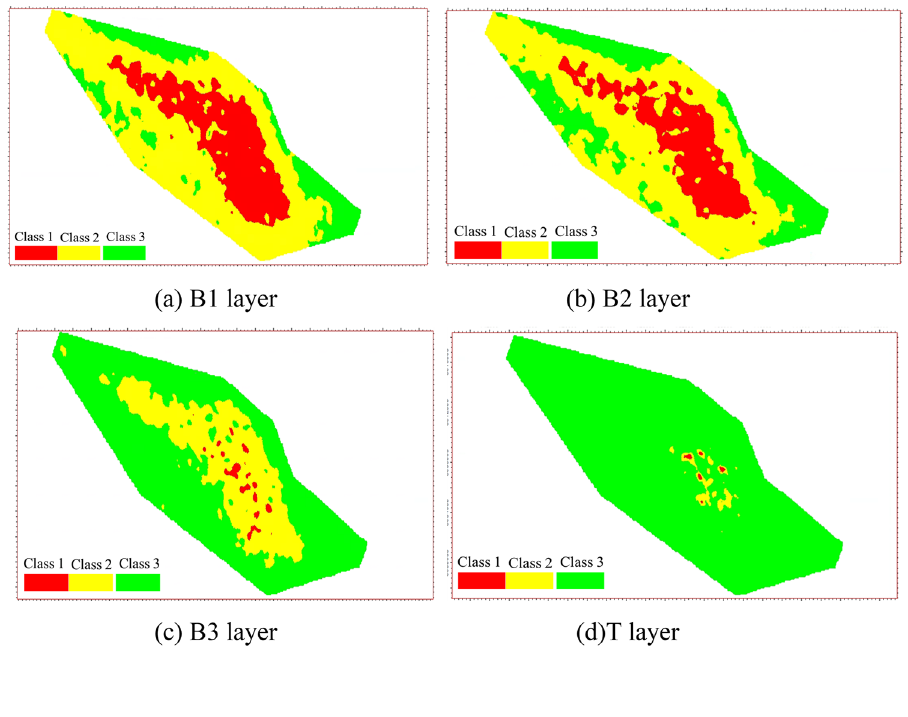
Fig. 20 Distribution of physical sweet spots